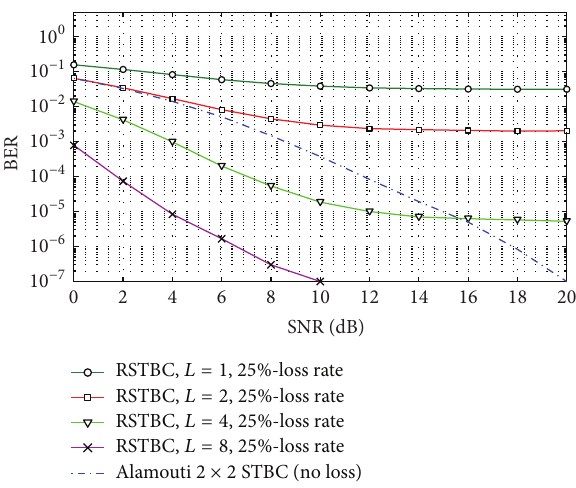
Figure 5: BER of RSTBC ( 𝐿 = 1, 2, 4, and 8) for MIMO system with QPSK and 25%-loss rate ( 𝑁 𝑡 = 2 , 𝑁 𝑟 = 2 , 𝑇 = 2